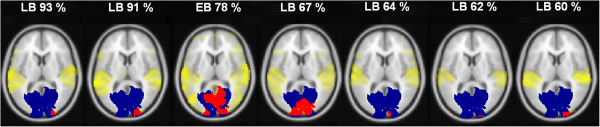
Individual occipital responses to ultra-fast speech in blind subjects. BOLD responses during the ultra-fast condition versus baseline (yellow color) obtained from the seven blind participants (1 early-blind = EB; 6 late-blind = LB) with a performance level of ultra-fast speech perception above 60% correctly repeated words. Activated voxels encroaching upon the anatomical mask of the primary visual area (V1 mask: blue color; V1 overlapping activation: red color) were predominantly located within the right hemisphere. Hemodynamic responses exceeding a threshold of p < 0.001 (uncorrected) at a voxel level are displayed on horizontal brain sections (x = 0, y = -84, z = 9).